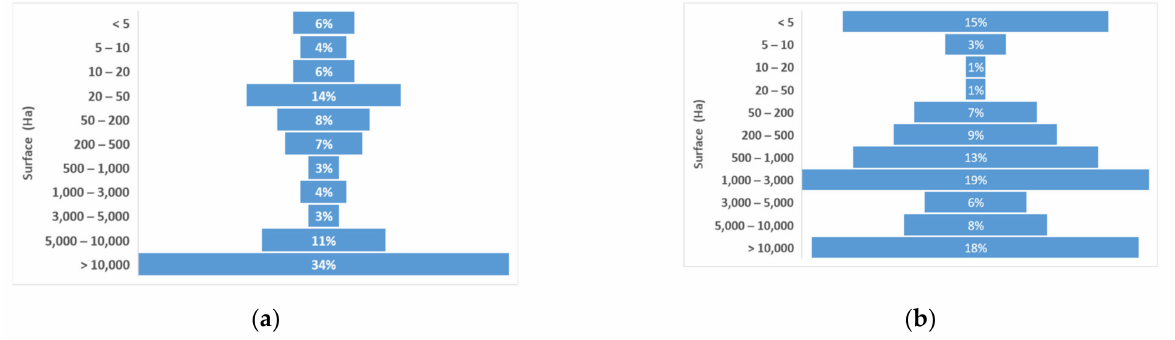
Figure 3. Statistical distribution of the surface area of Natura 2000 network protection figures in Extremadura (Spain): ( a ) SPAs and ( b )